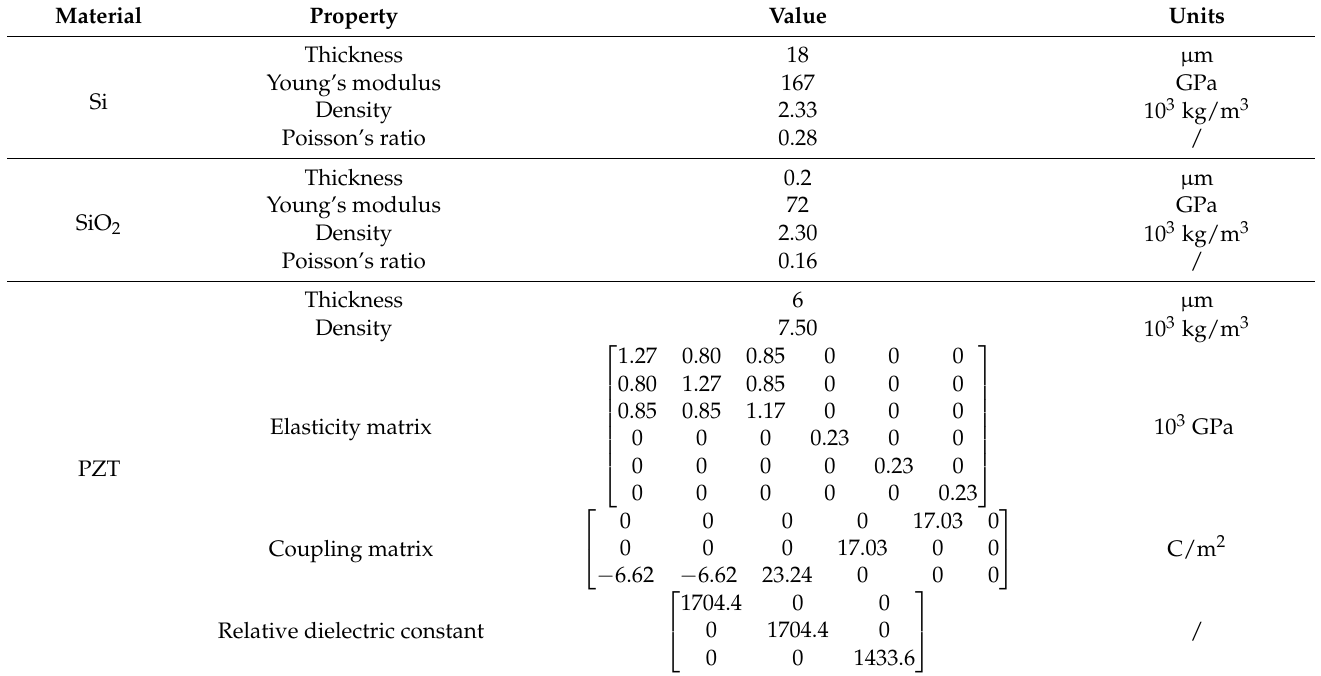
Table 2. Material characteristics and thickness used in FEM